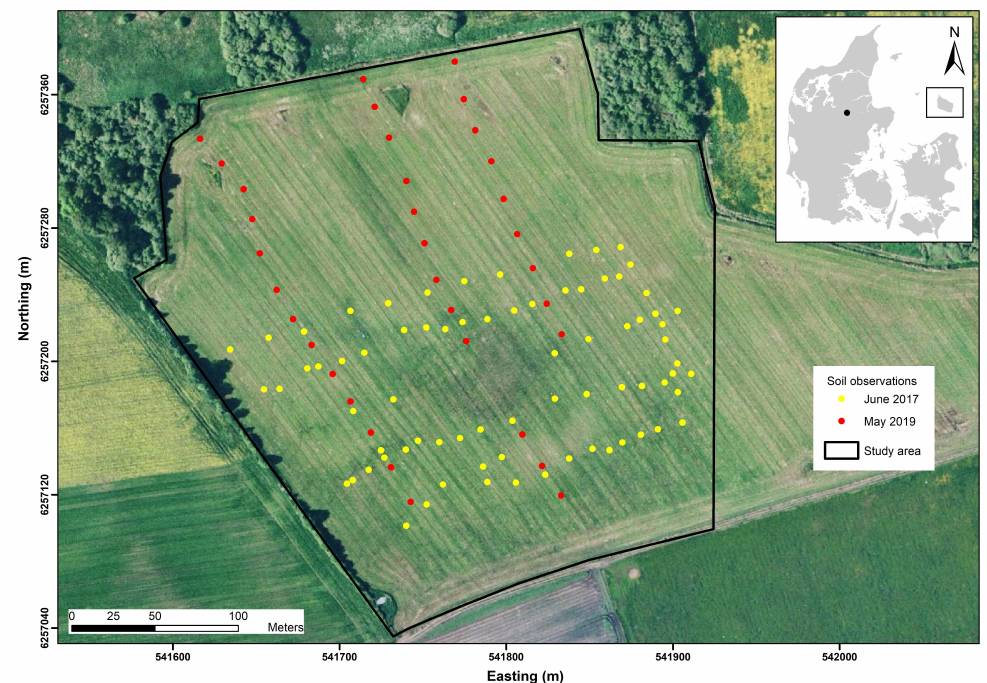
Figure 1. Location of soil observations collected during two sampling survey campaigns within the study area (orthophoto from the spring 2006 as background